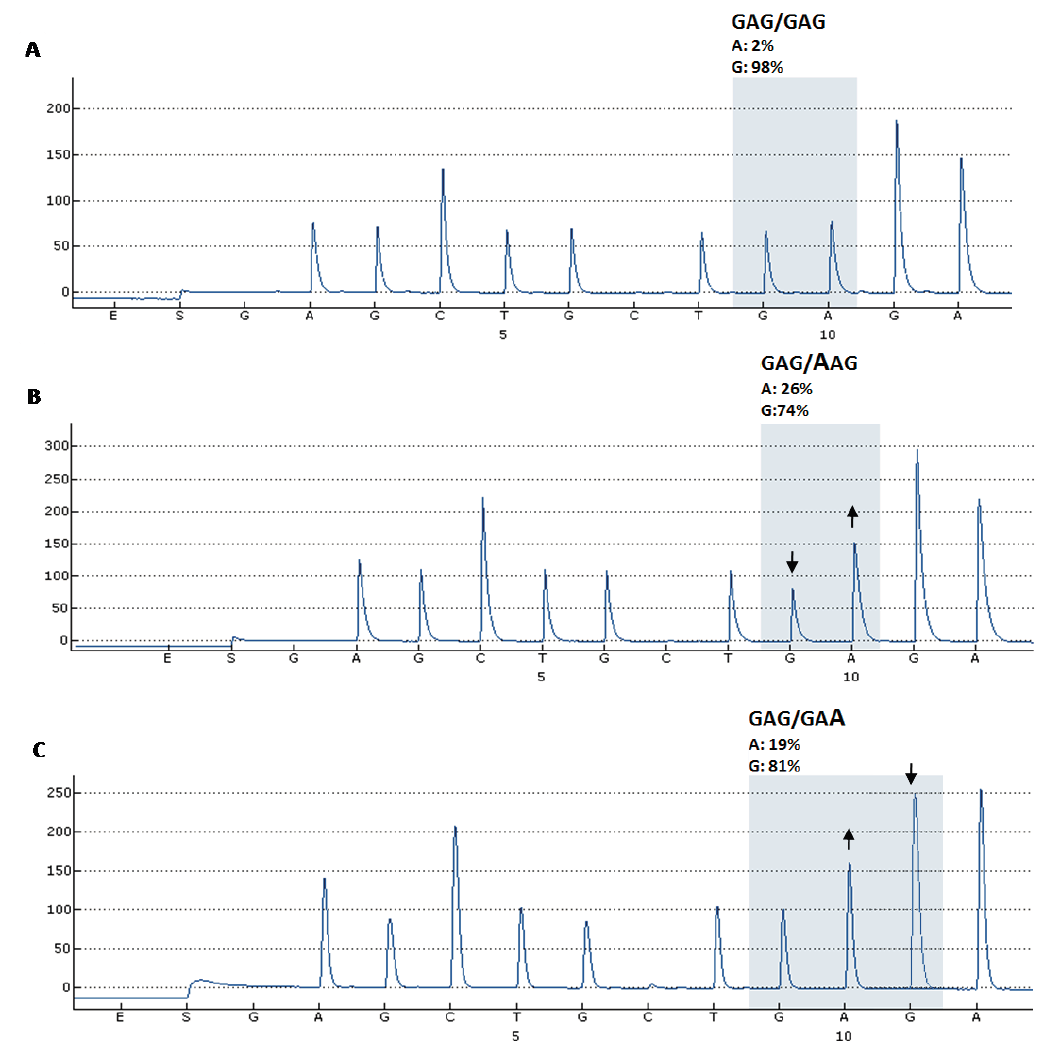
Figure 1. Representative pyrograms of the HER3 assay that detects E332K mutation and novel E332E synonymous mutation. ( A – C ) The nucleotide dispensation scheme during the E332 pyrosequencing assay is shown below each pyrogram. The ordinate axis displays signal intensity in arbitrary fluorescence units related to peak high. The shaded area of each pyrogram represents the nucleotides at the E332 somatic mutation site. The arrows show peak modifications corresponding to altered nucleotides at each somatic single nucleotide variant (sSNV) site. Allelic composition of the sSNVs and relative frequency of nucleotides adenine ( A ) vs. guanine ( G ) at a mutation site for a given position are indicated above each pyrogram. ( A ) Representative pyrogram trace of a tumor sample revealing a wild-type HER3 sequence at E332 site (GAG); ( B ) Pyrogram as displayed after an E332 pyrosequencing assay showing the classical E332K mutation, consisting of a substitution of an A nucleotide (upward-pointing arrow) in the place of a G nucleotide (downward-pointing arrow) at codon-first position; ( C ) Sequence analysis of the tumor sample harboring the novel E332E synonymous mutation, characterized as a substitution of an A nucleotide (upward-pointing arrow) in the place of a G nucleotide (downward-pointing arrow) at codon-third